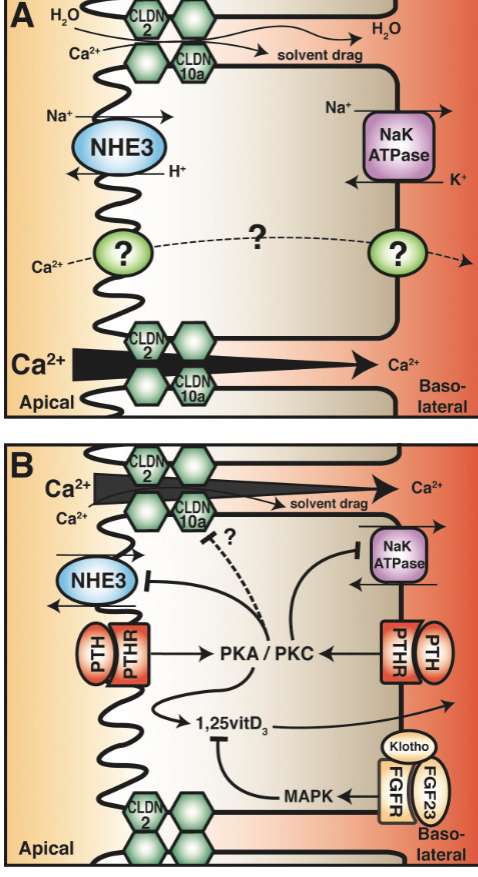
Figure 2. Proximal tubule (PT) calcium (Ca 2+ ) reabsorption. ( A ) Calcium reabsorption from the PT occurs primarily by a paracellular route, likely mediated by claudin-2 (CLDN2). This is dependent on transcellular sodium reabsorption, driven by the sodium proton exchanger (NHE3) and sodium potassium ATPases. The reabsorption of sodium generates an osmotic gradient for water reabsorption, which in turn drags other solutes (including calcium) in a process known as solvent drag (top junction). In the late PT, the calcium concentration gradient favours reabsorption (from apical to basolateral) as the majority of sodium and water reabsorption occurs in the early PT (bottom junction). The transcellular calcium reabsorption pathway, present in late PT, is illustrated as a dashed line. ( B ) Parathyroid hormone (PTH) in the PT decreases calcium reabsorption by attenuating its driving force. PTH in both the tubular fluid and the blood binds its receptor (PTHR), which is expressed on both apical and basolateral membranes. This activates the downstream messengers protein kinase A (PKA) and protein kinase C (PKC). Note that apical PTHR preferentially activates PKC. Both pathways inhibit NHE3 activity and reduce abundance, but only PKC inhibits Na + /K + ATPase activity. PTH also reduces tight-junction permeability in the PT and enhances active vitamin